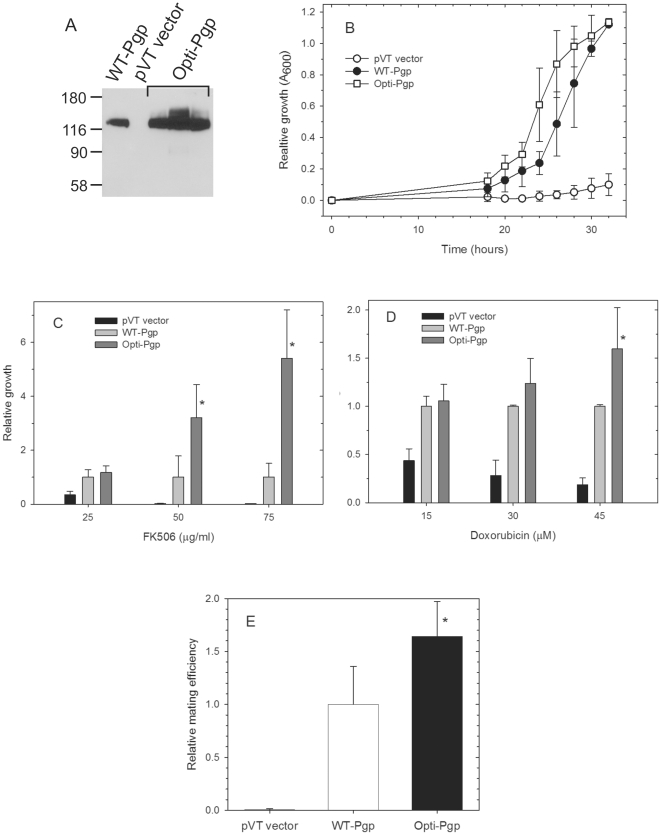
Protein expression levels and in vivo biological activity of WT- and Opti-Pgp in S. cerevisiae.A) Three independent pVT-opti-mdr3 clones were transformed into S. cerevisiae, microsomal membrane proteins (15 µg) of mass populations resolved on a 10% SDS-gel and the Western blot probed with the Pgp-specific monoclonal C219 antibody (Covance SIG-38710). Mass populations transformed with pVT vector alone or the WT gene served as controls. The positions of the MW protein markers are indicated in kDa. B) Growth resistance to the fungicide FK506 (50 µg/ml) was monitored at A600 for wild-type Pgp (WT-Pgp), gene-optimized Pgp (Opti-Pgp) and control pVT vector transformants. Data points represent the mean ± standard deviations of three independent transformants assayed in triplicate in four independent experiments; where not visible, error bars are smaller than the plot symbol. C) Growth of individual mass populations in the absence or presence of increasing concentrations of FK506 (25, 50 and 75 µg/ml) was measured at A600 after 25-26 hours and is expressed as growth relative to WT-Pgp. D) Growth resistance in the absence or presence of doxorubicin (15, 30 and 45 µM) was measured relative to WT-Pgp. E) Mating frequency represents the proportion of transformed a-type JPY201 cells that formed diploids upon mating with R-type tester cells DC17, followed by plating on minimal medium [34]. Values are expressed as a percentage of the WT frequency ± the standard deviation of four experiments using three independent transformants. Asterisks indicate significant differences between WT- and Opti-Pgp (p<0.05).